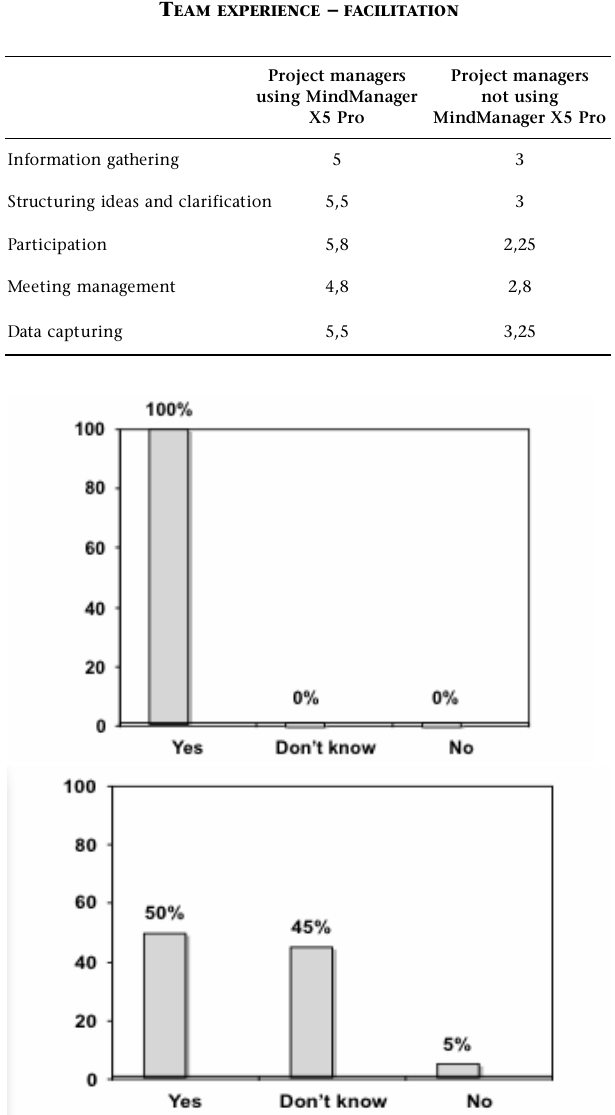
Figure 1: Did Mindmanager X5 Pro Add Any Value As A Project Management Tool?